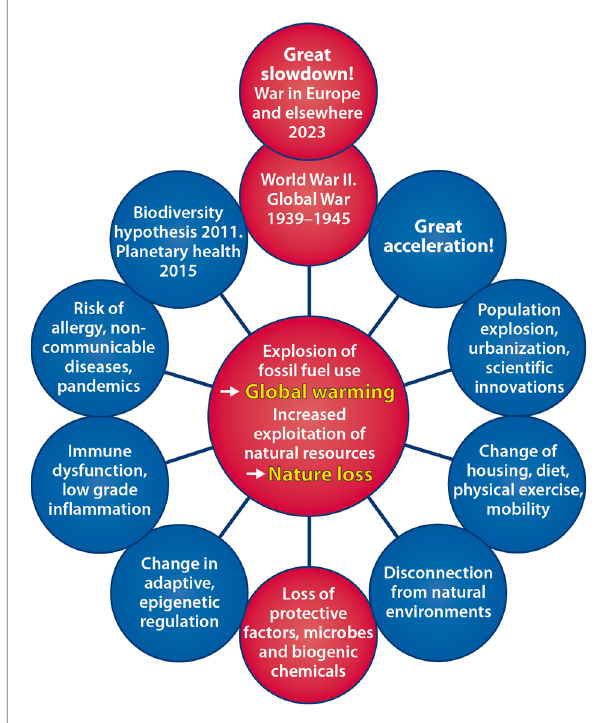
FIGURE 5 Health wheel going around. From the disaster of World War II to great acceleration with population explosion, urbanization, and changes of environment and lifestyle. Overuse of natural resources has kept the wheel going but is causing climate crisis and nature loss with major health impact. Coming around to ongoing military con fl icts in Europe and elsewhere denotes great slowdown